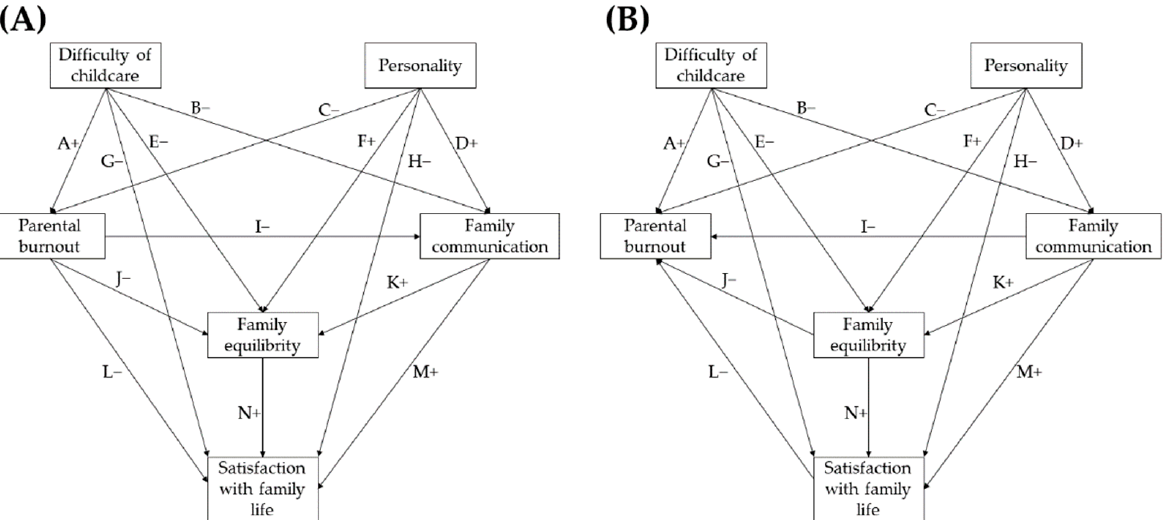
Figure 1. The main ( A ) and alternative ( B ) set of hypotheses models of causal correlation between difficulty of childcare, maternal personality, maternal burnout, and three features of family functionality. Sign (+ or –) are expected correlations (positive or negative).